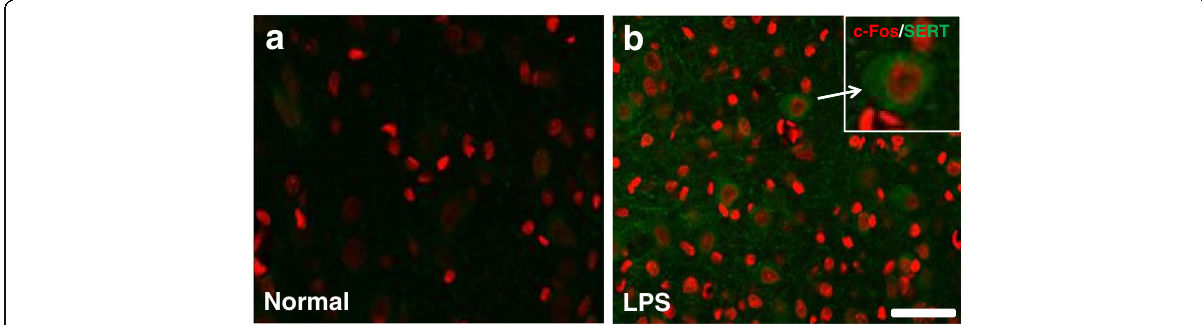
Fig. 4 Expression of SERT in activated neurons in the DRN. a, b Representative images of expression of SERT (green) and c-Fos (red) in the DRN of normal ( a ) and LPS-treated rats ( b ). Enlarged image in ( b ) shows a DRN neuron double-labelled with SERT/c-Fos. Scale bar = 50 μ m